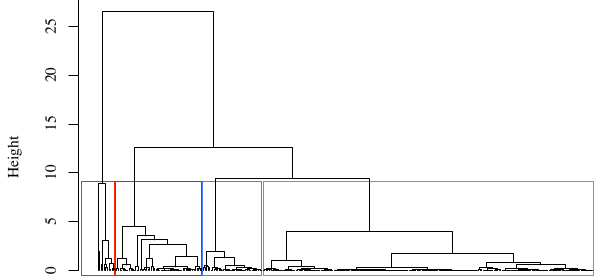
Fig. A2. Cluster analysis of pigment data. Framed rectangles in red, green, blue, and purple represent cluster group A, B, C and D, re-